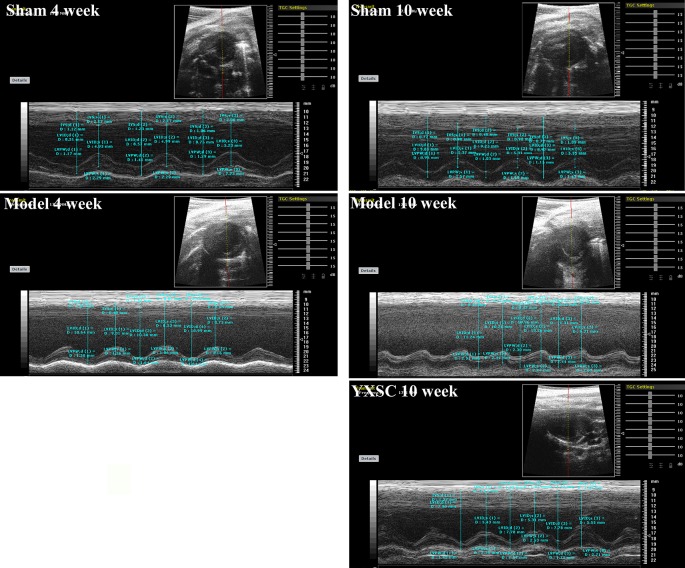
Representative echocardiographic in sham group, model group and YXSC group.